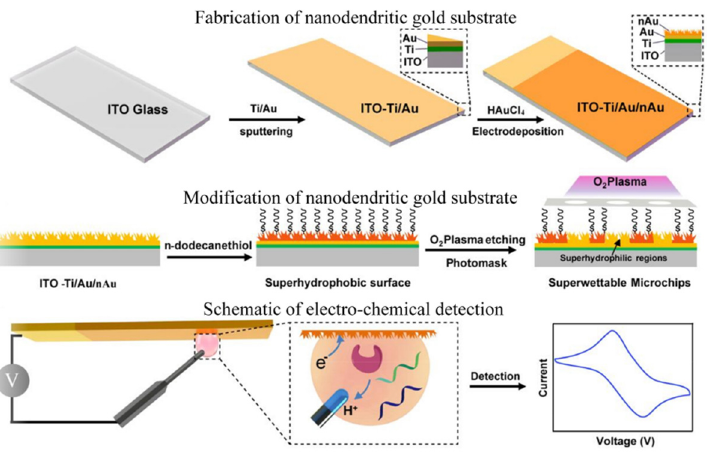
Figure 13. Design of ultra-wettable electrochemical microchips for biosensing [200].